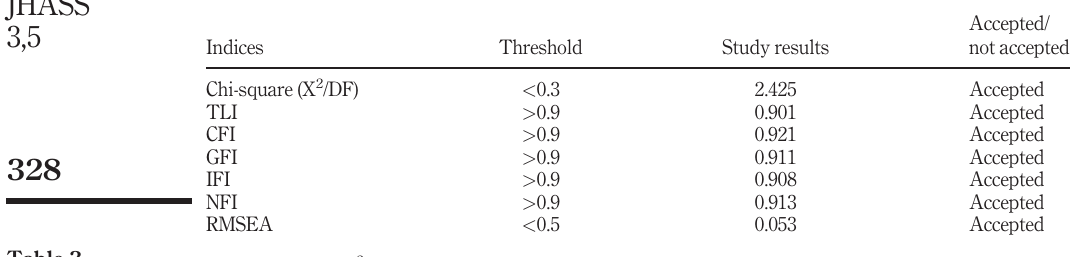
Table 3. Summary of CFA